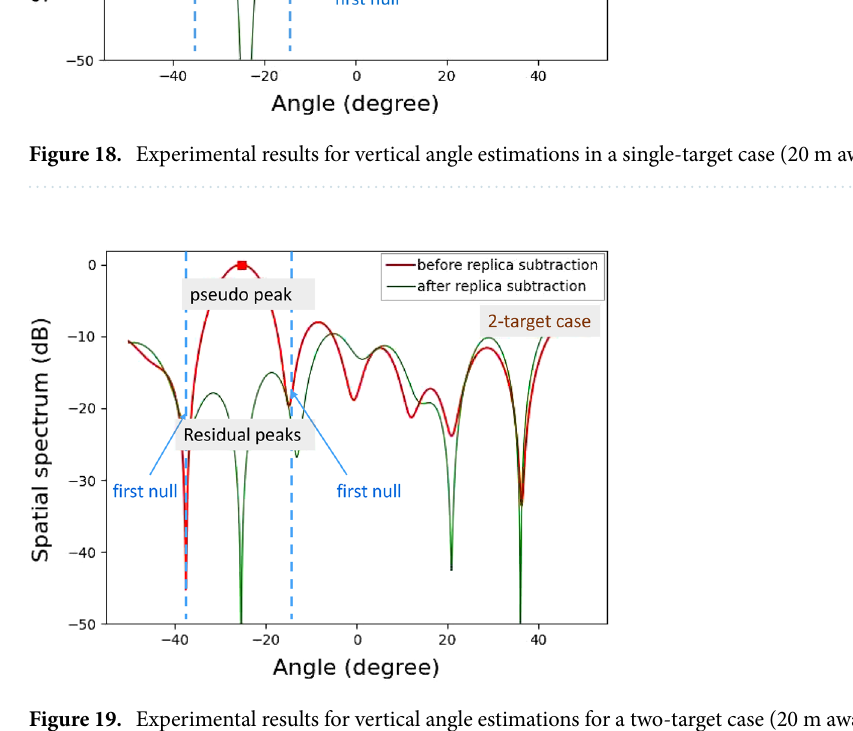
Figure 19. Experimental results for vertical angle estimations for a two-target case (20 m away with targets having the same radar cross-sectional